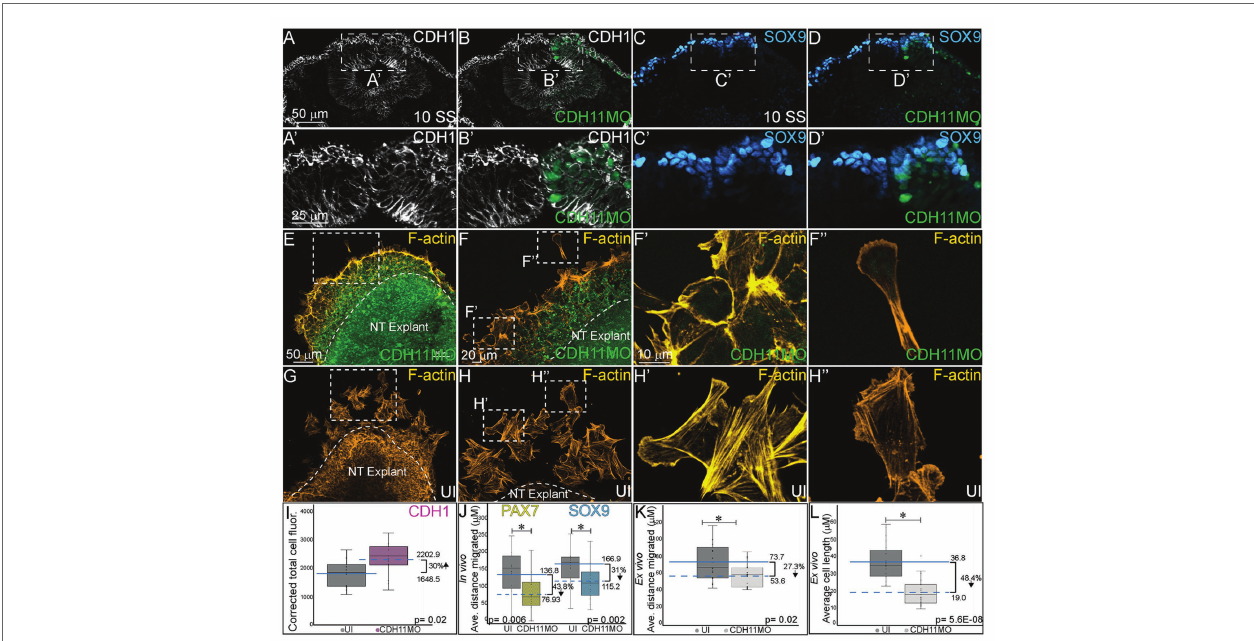
FIGURE 6 | CDH11 knockdown affects cell morphology and NC cell migration. To determine if the NC determination and cell death phenotype affects cell morphology in vivo (A–D’) embryos were injected unilaterally with CDH11MO and electroporated at HH4, and IHC was performed for (A–B’) CDH1 to mark epithelial cells and (C–D’) SOX9 to mark definitive NC cells. Dashed boxes in (A-D) indicate location of zoom in from (A’–D’) .To determine if the CDH11 knockdown phenotype affects cell morphology and migration ex vivo (E–H”) neural tube explants were dissected from HH8 embryos, cultured on fibronectin coated slides, and stained for filamentous actin (F-actin). (A) IHC for CDH1 in transverse section from 10 SS embryo with (B) overlay with CDH11MO (green). (A’) Zoom in of dashed box from (A) showing increased CDH1 expression in dorsal neural tube in CDH11MO-injected versus uninjected side. (B’) Overlay with CDH11MO. (C) IHC for SOX9 in transverse section from the same 10 SS embryo from (A) with (D) overlay with CDH11MO (green) demonstrating reduced migration on CDH11-injected side. (C’,D’) Zoom in of dashed box from (C,D) . (E-F”) Staining for F-actin in explant from embryo unilaterally injected with CDH11MO and electroporated at HH4, at (E) 20X and (F) 40X magnification. (F’) Zoom in of single follower cell from CDH11MO-injected explant. (F”) Zoom in of single leading cell from CDH11MO- injected explant. Both cells are significantly closer to epithelial explant and smaller than uninjected cells. (G–H”) Staining for F-actin in explant from uninjected side at (G) 20X and (H) 40X magnification. (H’) Zoom in of grouped follower cells from uninjected explant. (H”) Zoom in of single leading cell from uninjected explant. (I) Graph showing in vivo difference in CDH1 between uninjected and CDH11MO-injected sides. Corrected mean total cell fluorescence of CDH1 in the dorsal neural tube is 1645.5 on uninjected and 2202.9 on CDH11MO-injected side, p = 0.02, n = 11. (J) Graph showing difference in migration in vivo from midline of PAX7 and SOX9-positive cells between uninjected and CDH11MO-injected sides. Average distance migrated away from midline by PAX7+ cells is 136.8 μ m on uninjected